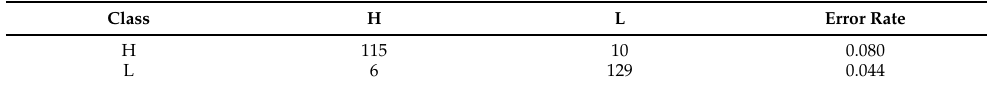
Table 5. RFC confusion matrix 1 .